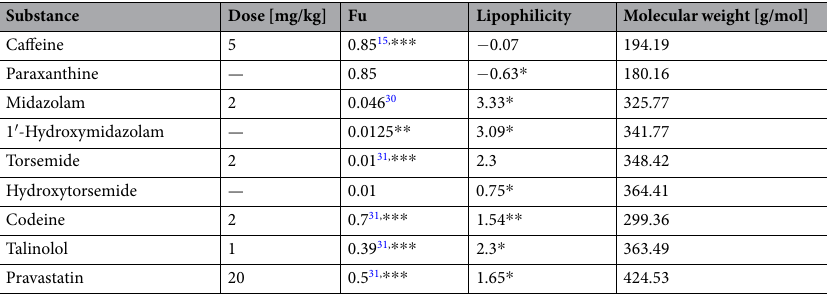
Table 2. Physicochemical parameters used in the PBPK models. * Literature ** optimized *** human value.